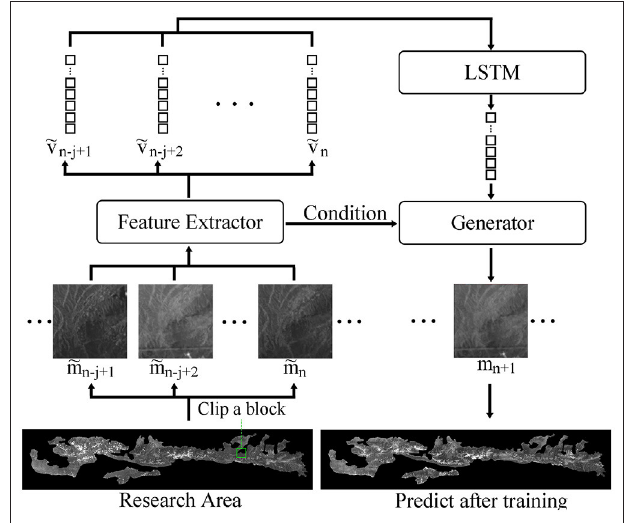
FIGURE 4 | Data flow of the